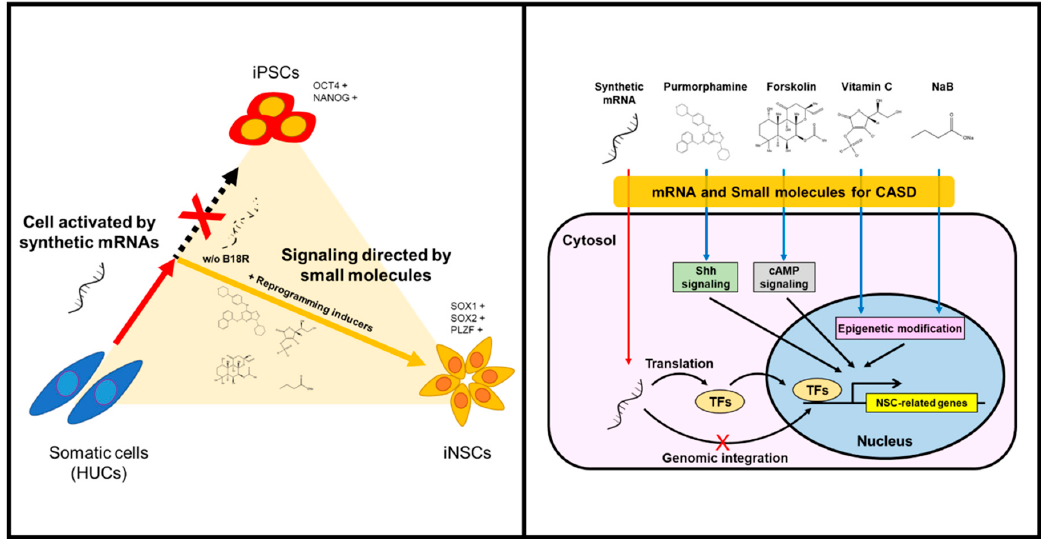
Figure 8. Schematic illustration of generating iNSCs from HUCs.